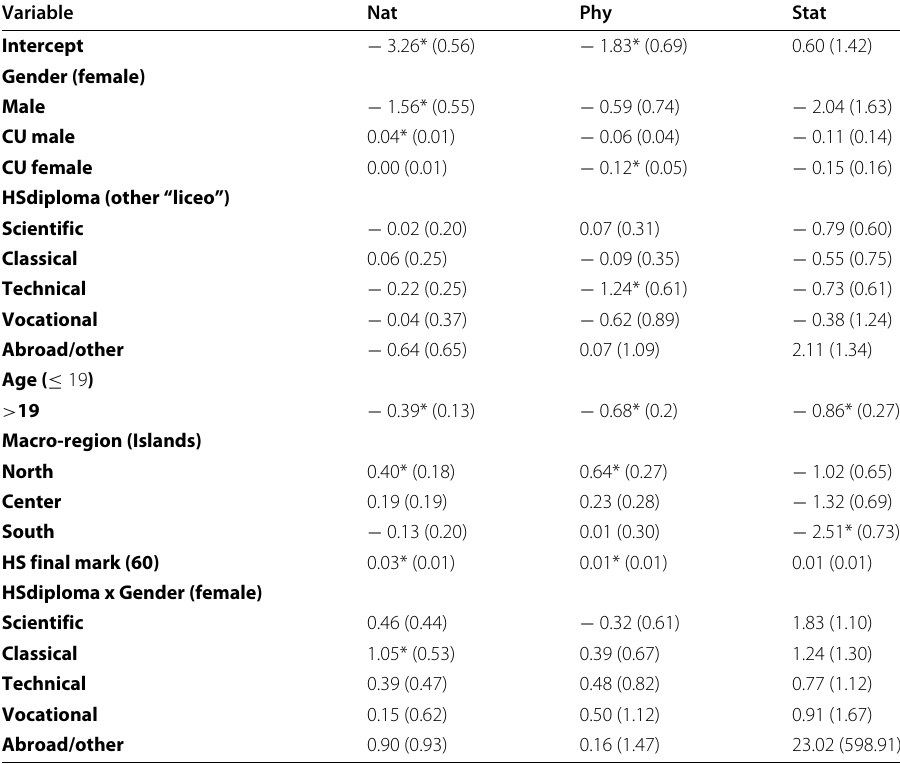
Table 7 Parameter estimates θ ’s of the segmented regression models by degree course Variable